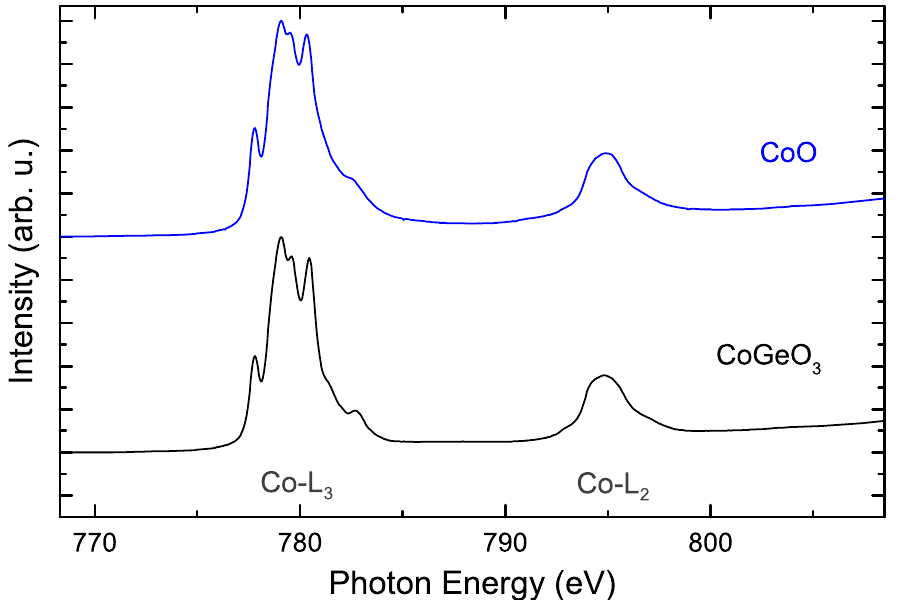
Figure 4. (Isotropic) X-ray absorption spectra of CoGeO 3 and of CoO at the Co L 2,3 edge.